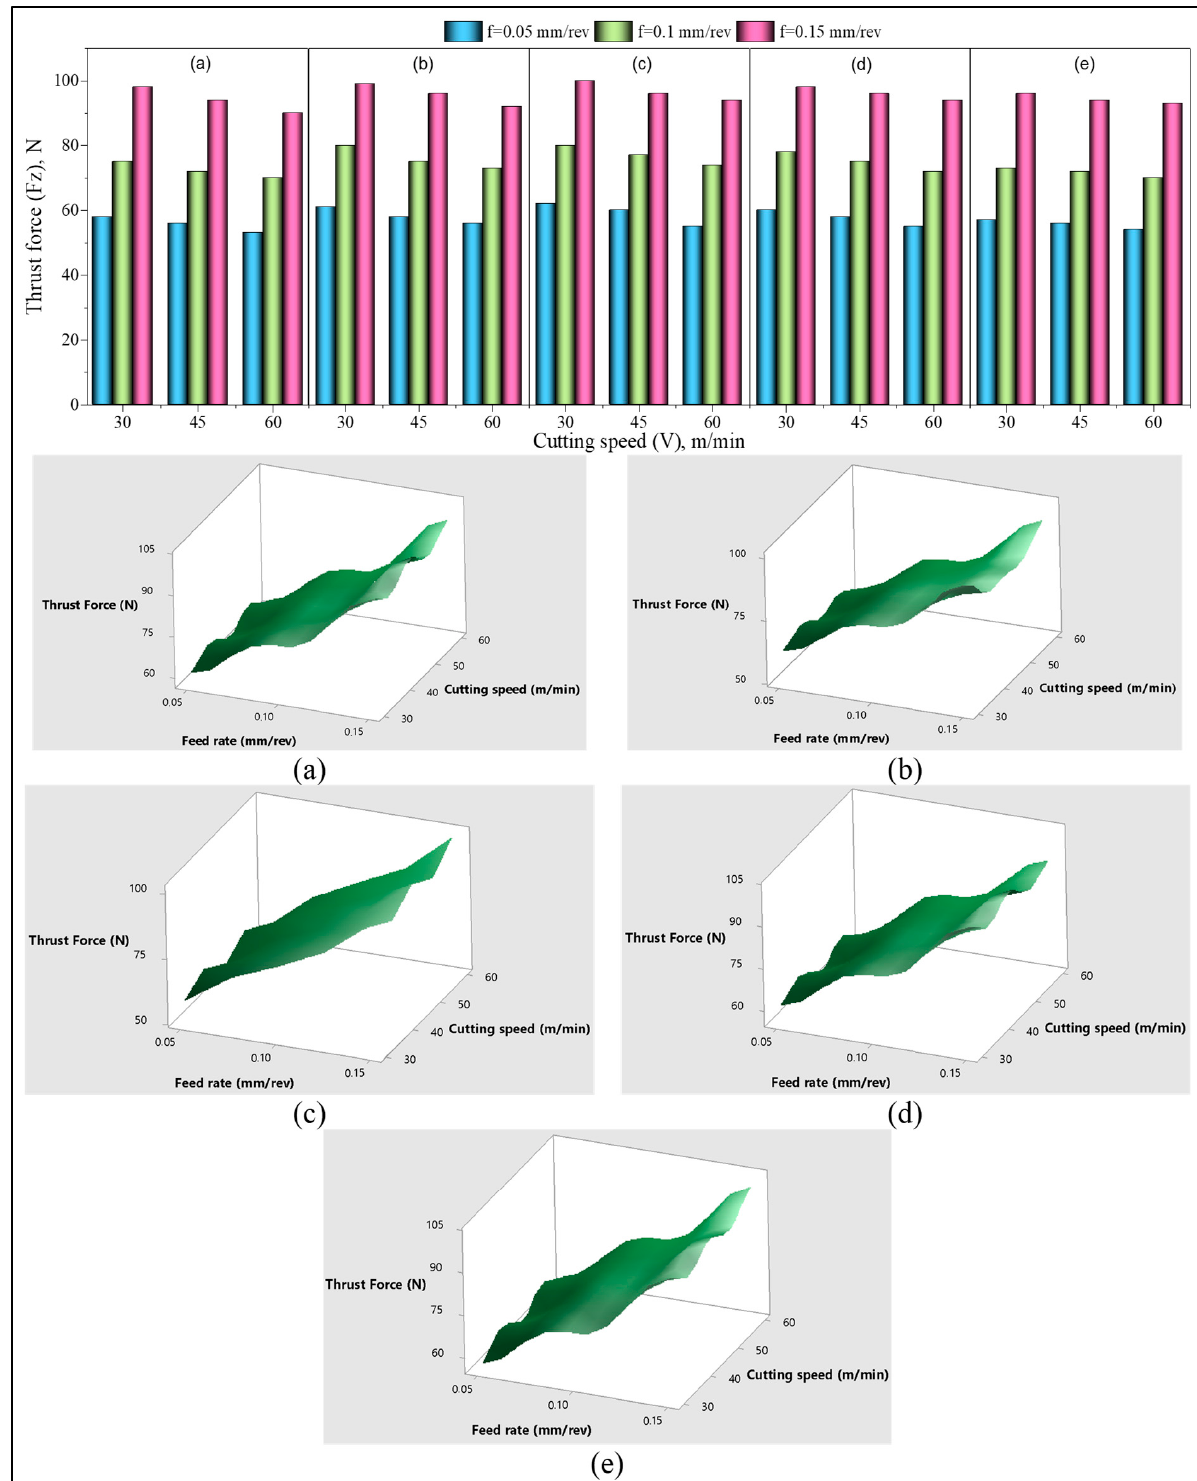
Figure 4. Thrust force (Fz) variation versus drilling parameters with 2D bar and 3D surface plots: